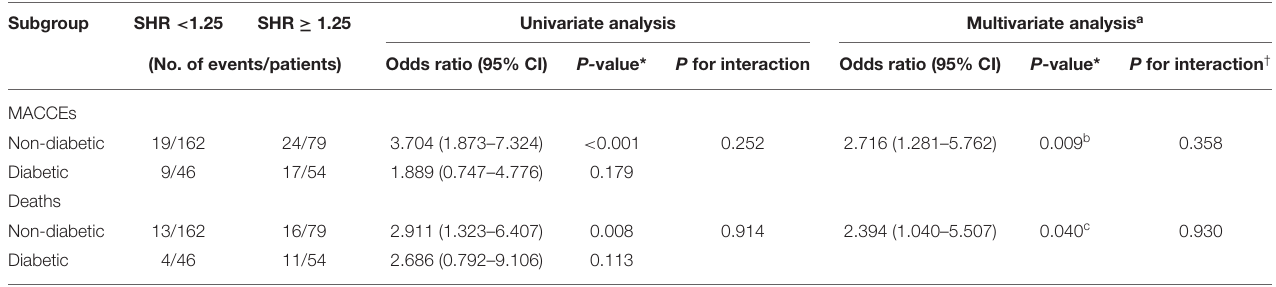
TABLE 5 | Subgroup analysis based on the diabetic and non-diabetic